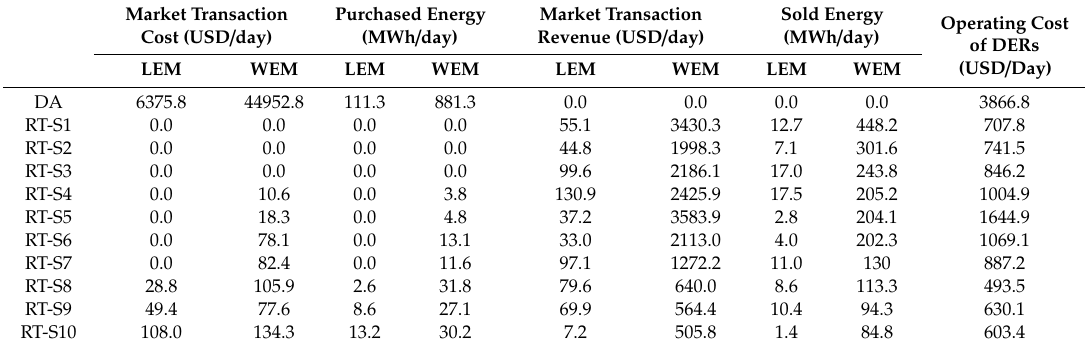
Table 7. DSO’s cost, revenue, and exchanged energy during the whole